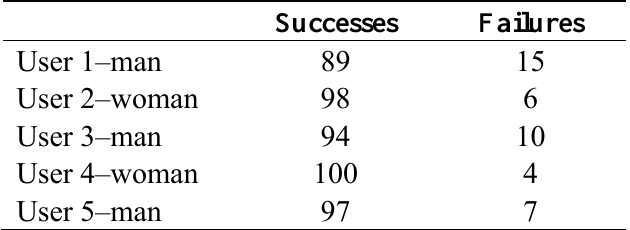
Table 1. Experiment